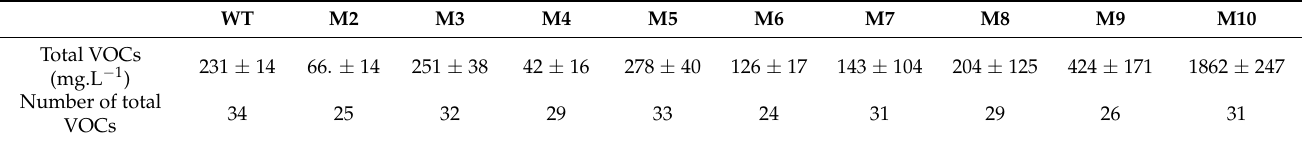
Abbreviation: WT, wild type of S. suaveolens ; M2, M3, M4, M5, M6, M7, M8, M9, M10, and ILV- mutants of S. suaveolens produced by UV mutagenesis. The VOCs were determined after 48 h of growth at 30 ◦ C on YNB-Glu-Ile agar medium and expressed in mg.L − 1 . Data shown are the mean ± SD of three independent